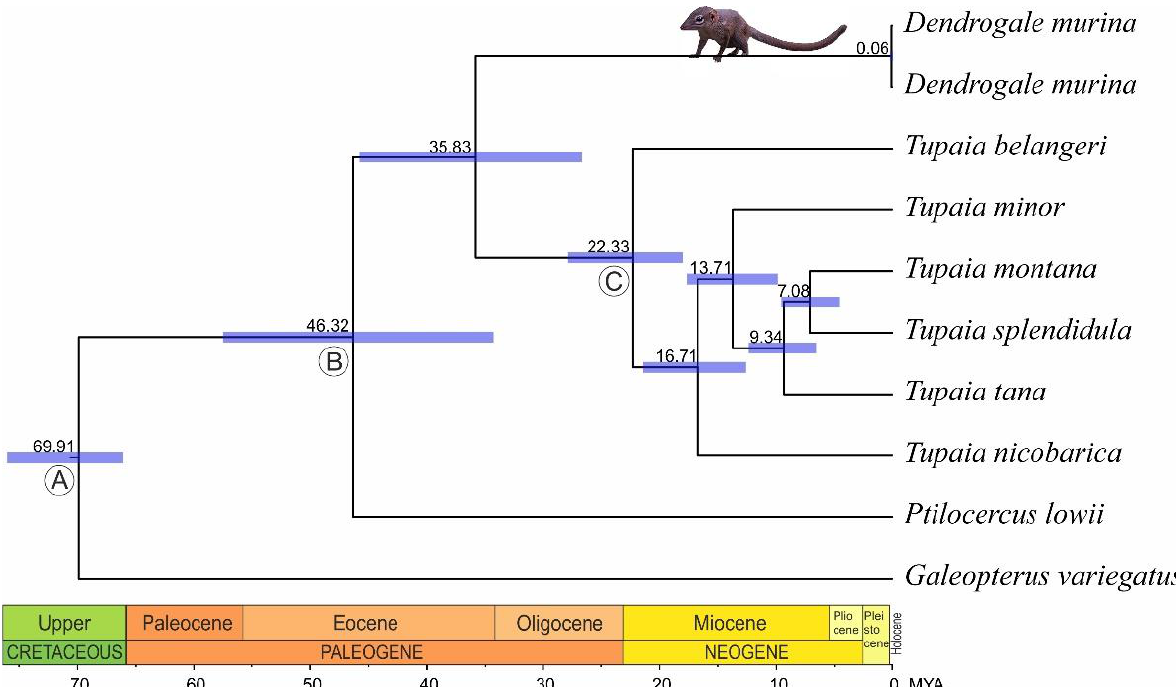
Figure 3. Bayesian phylogenetic reconstruction of Scandentia inferred from mitochondrial genomes. Posterior probabilities are 1.0 at each node. The divergence times (in MYA) were estimated by three calibration points (A, B, and C). Node labels represent mean node ages, and blue bars represent 95% highest posterior density (HPD) around mean estimates of divergence times. Tree topology and node bars were visualized in FigTree v1.6 and edited manually in CorelDRAW X8. The separation time of the Dendrogale genus is estimated as an average of 35.8 MYA